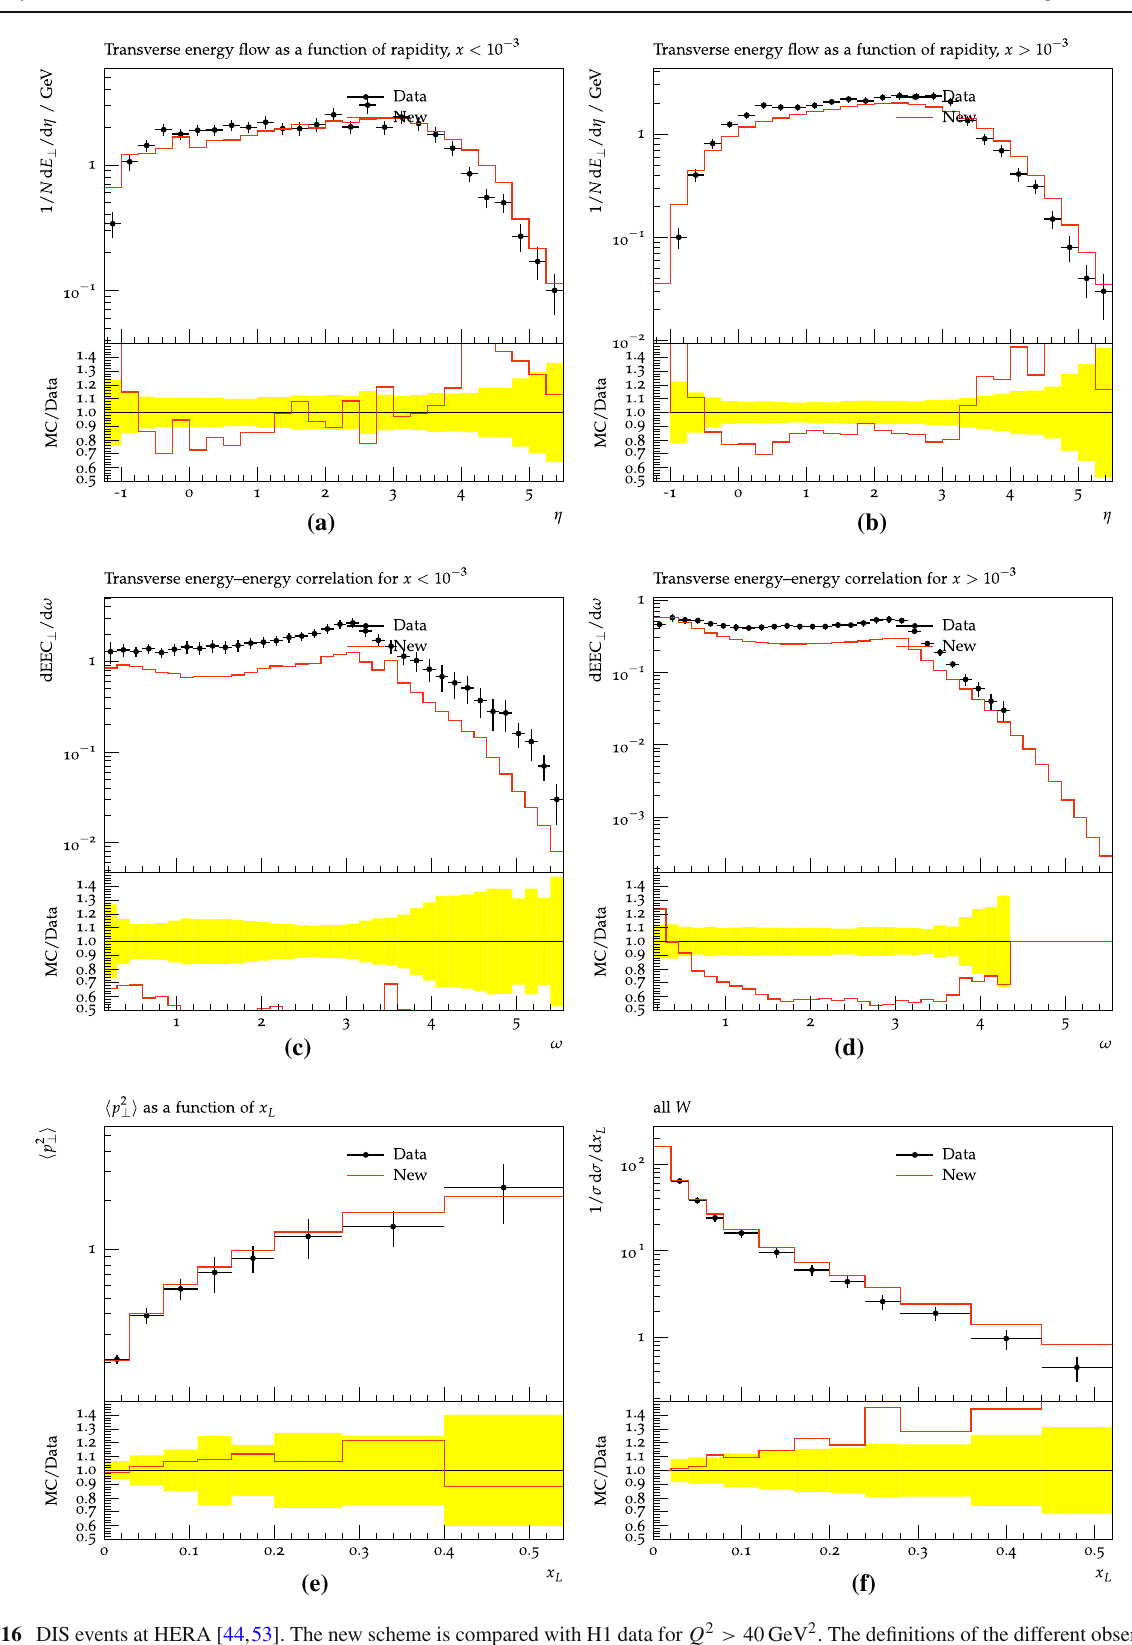
Fig. 16 DIS events at HERA [44,53]. The new scheme is compared with H1 data for Q 2 > 40GeV 2 . The definitions of the different observables can be found in